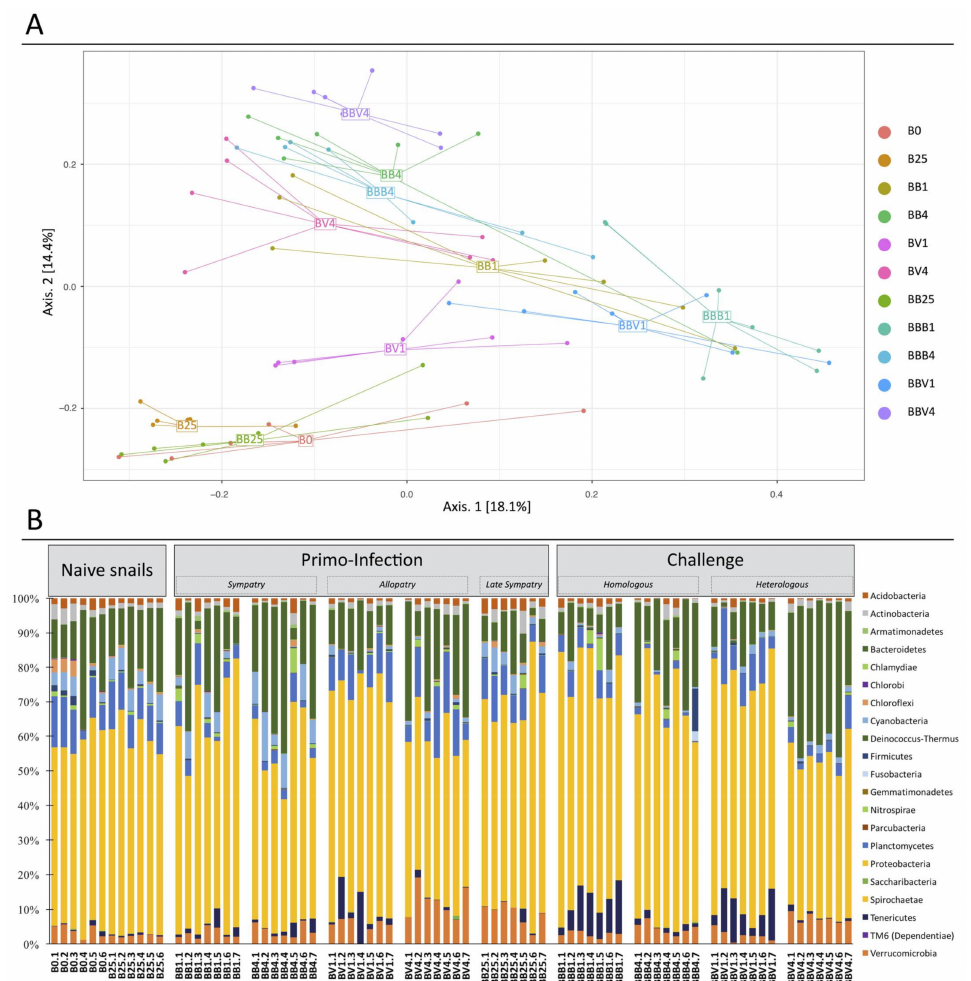
Figure 4. Beta diversity and bacterial communities following Biomphalaria infection: Dynamics of the bacterial microbiota of Biomphalaria glabrata following Schistosoma primary infection and secondary challenge. ( A ). Functional diversity comparisons of Biomphalaria microbiota along the infection. Principal coordinate analysis of pairwise Bray–Curtis distances across all infection type and time samples. Axes represent the two synthetic variables explaining the greatest proportion of variation in the data set. The sample name indicated in the figure corresponds to the centroid of all the biological replicates points of the respective experimental sample. ( B ). Phylum level composition of the 20 most abundant OTUs among all points of the kinetic. In this representation, the replicate naive snails were pooled for more